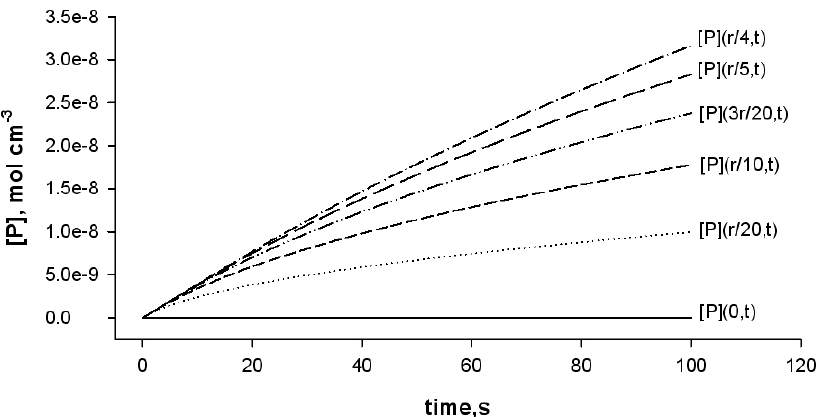
Figure 1. Product concentration increase with time at different space points. Starting from the point 4 rx = the obtained product concentration (data not shown) is the same as in the case of .